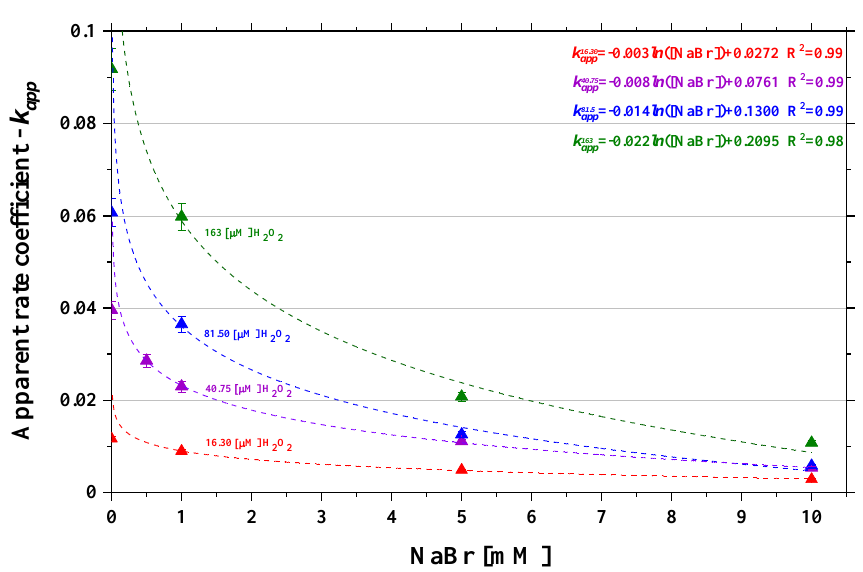
Figure 4. Apparent rate coefficients ( k app ) as a function of NaBr concentrations, in the presence of different H 2 O 2 concentrations in µM (16.3, 40.75, 81.5 and 163 represented by the different colors: red, purple, blue and green respectively). Dashed plots represent a logarithmic regression fitting as described by the equations.